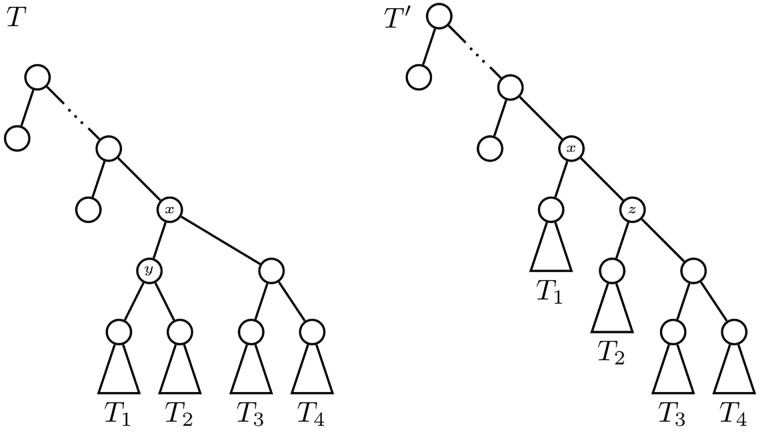
The trees T and T′ in the proof of Lemma 1.